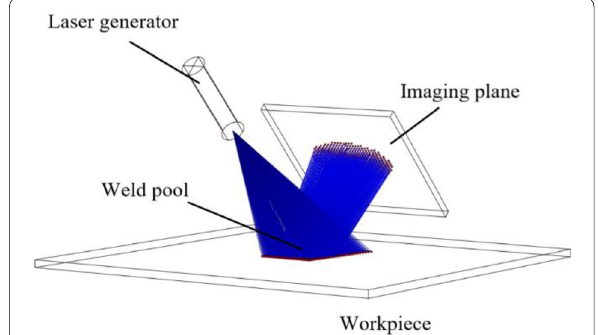
Figure 5 Integrated pool simulation